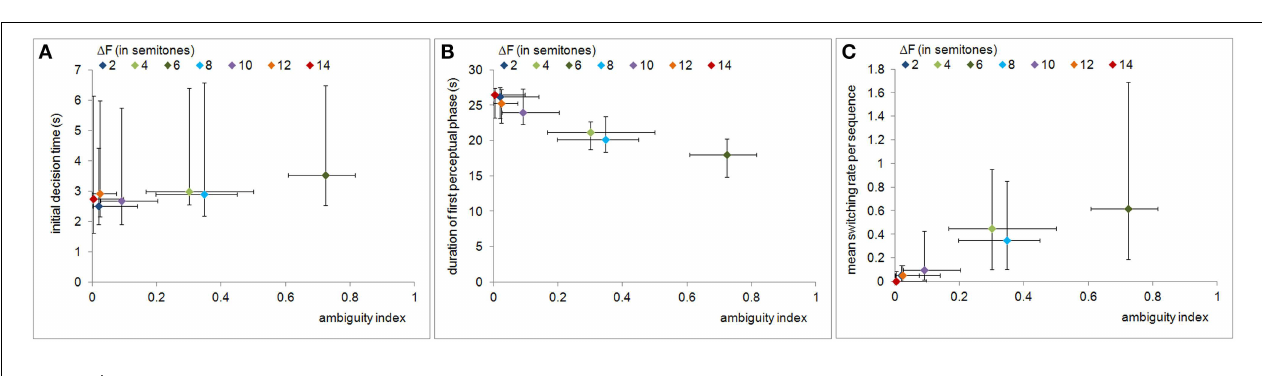
(B) , and the mean switching rate (C) . Symbols and error bars represent medians and the 25th and 75th percentiles, respectively. All behavioral measures are significantly correlated with the ambiguity